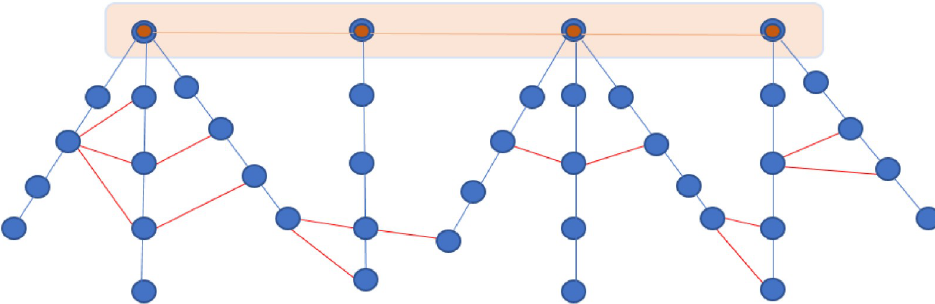
Fig 2. Graph representing a multi-modal integrated network with train (orange links), bus (blue links) and non- motorized modes (red links).